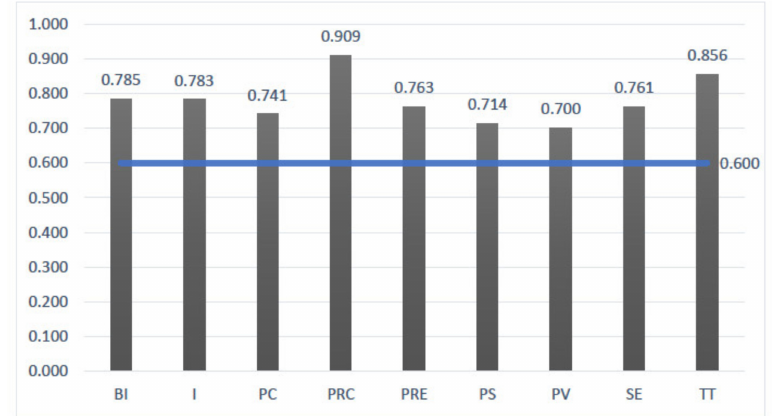
Figure 4. Cronbach’s